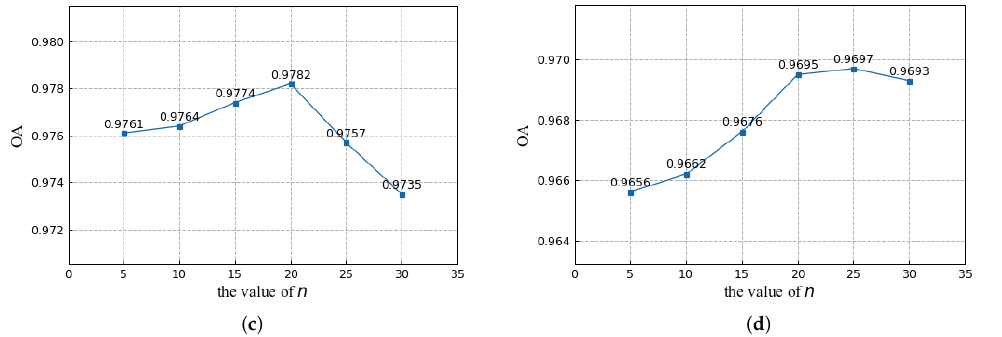
Figure 14. Analysis of the number of groups n . ( a ) Bastrop dataset. ( b ) Umatilla dataset. ( c ) Yancheng dataset. ( d ) River dataset.